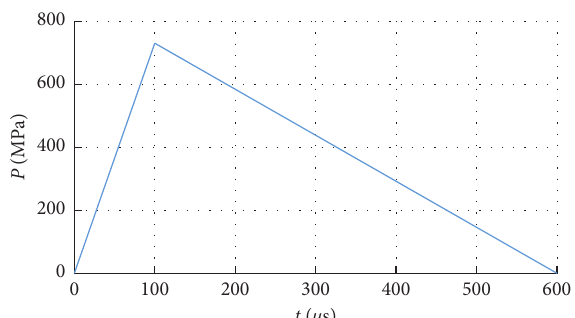
Figure 7: Time-history curve of the blasting load on the slope